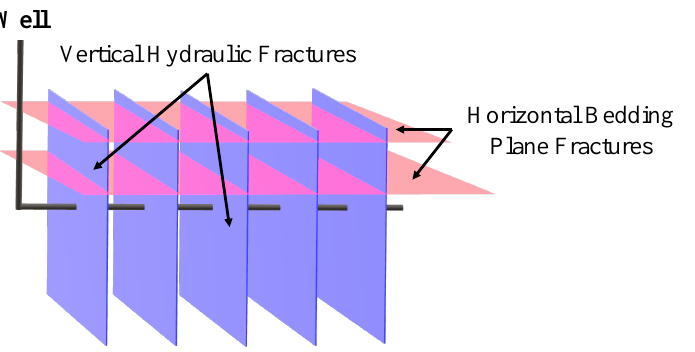
Figure 9. Schematic figure of the horizontal bedding plane fractures. Adapted from: